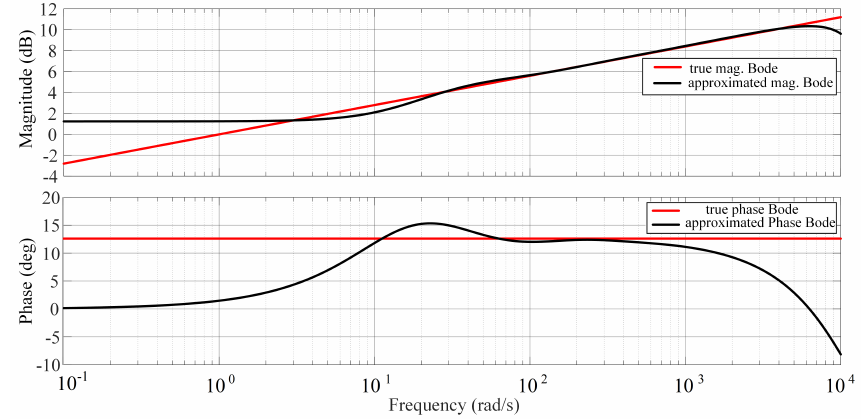
Figure 8. Comparison of approximated bode diagram and true bode diagram.